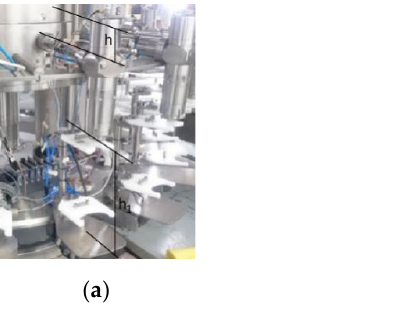
Figure 7. System parameters varied during the tests ( ℎ and ℎ 1 ). ( a ) Parameters highlighted on a weight filler station. ( b ) Schematic representation of a station.